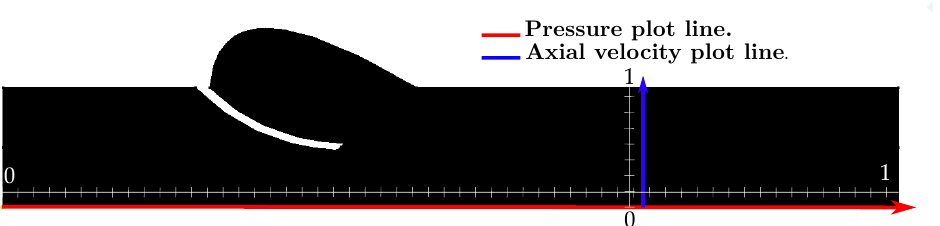
Pressure plot line. Axial velocity plot line . 1